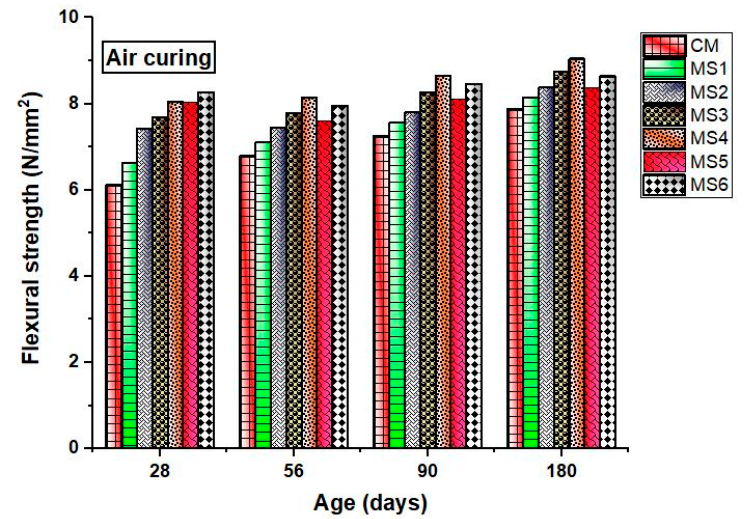
Figure 6. Flexural strength of the concrete mixes in air curing at various ages.